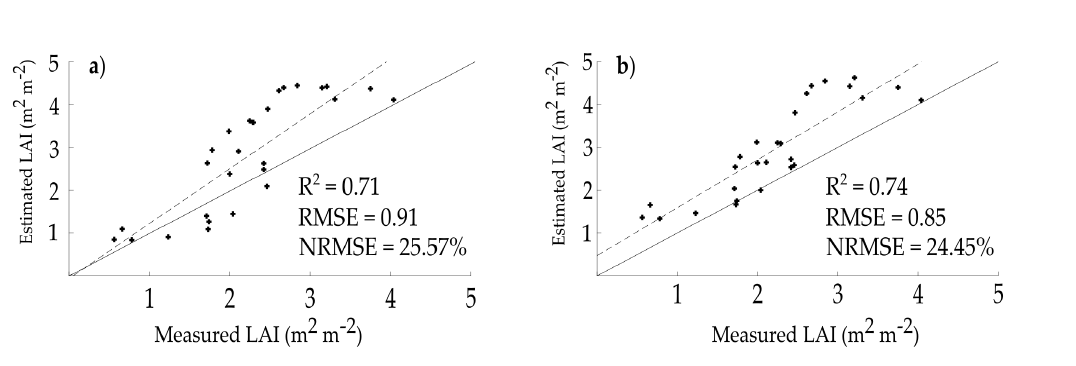
Figure 5. The estimated LAI from LUTstd ( a ) and LUTreg ( b ).